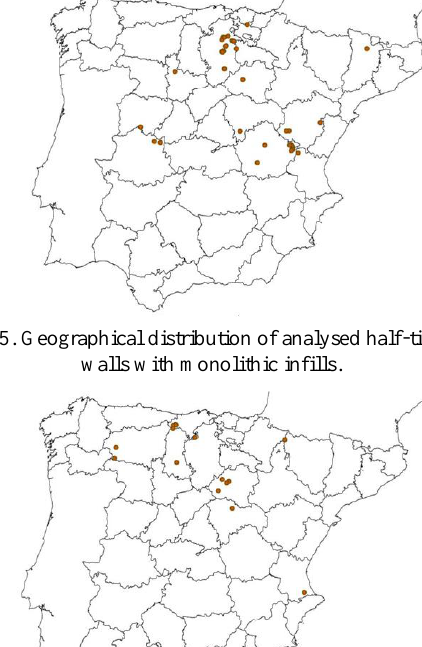
Figure 4. Geographical distribution of analysed half-timbered walls with masonry infills.